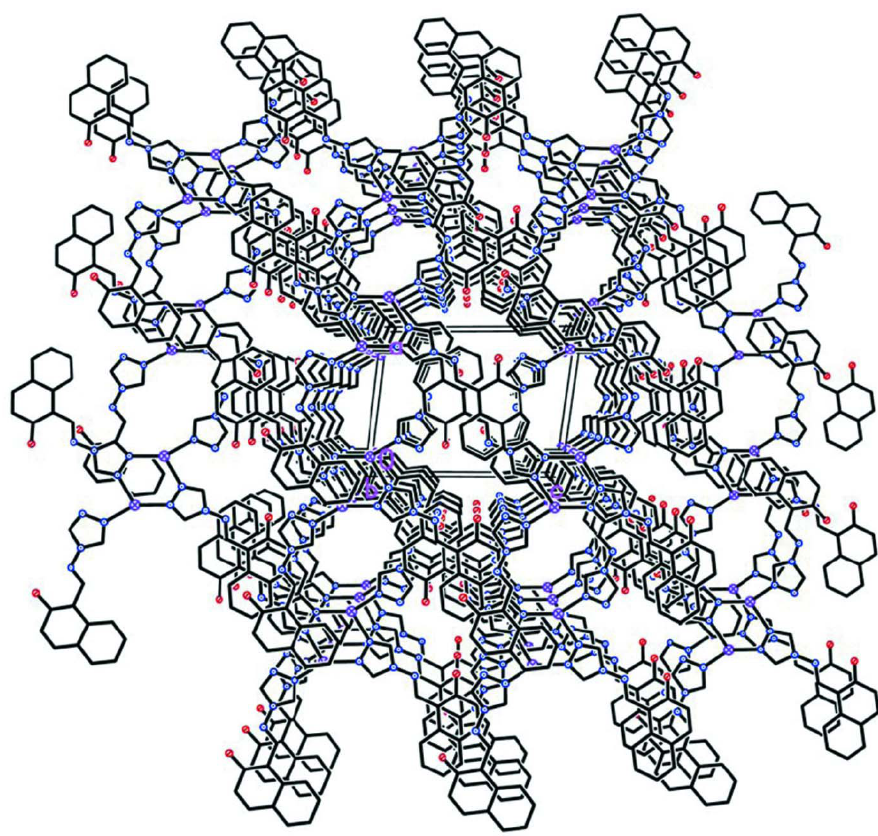
Figure 2 A packing diagram for the crystal along b axis, the NO 3- , H